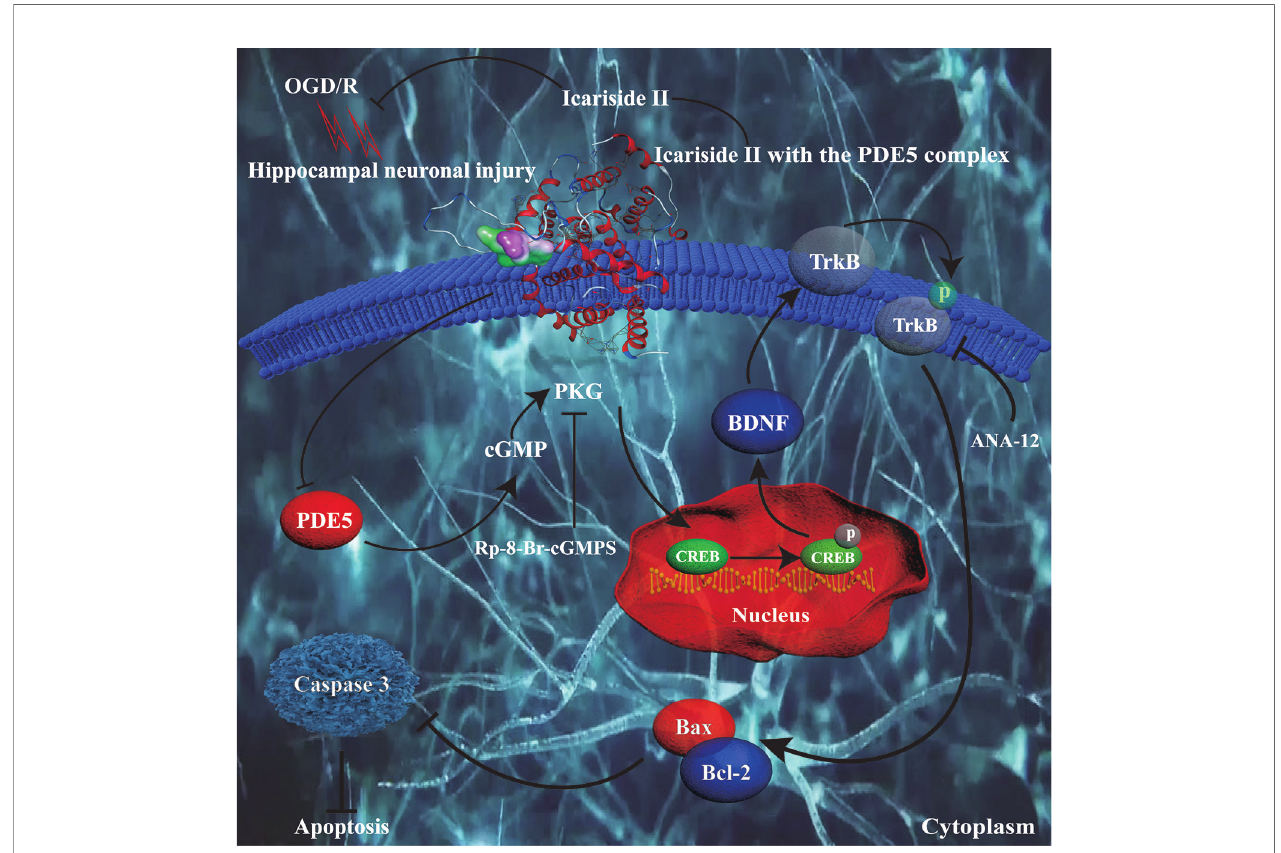
FIGURE 6 | Presentation of a proposed mechanism for the neuroprotective role of ICS II against OGD/R-induced injury in primary hippocampal neurons. ICS II is thought to direct bind and inhibit PDE5, thereby elevating cGMP level and PKG activity. Then, cGMP promoted PKG/BDNF/TrkB/CREB pathways, thereby reducing neuronal apoptosis and assisting neuronal